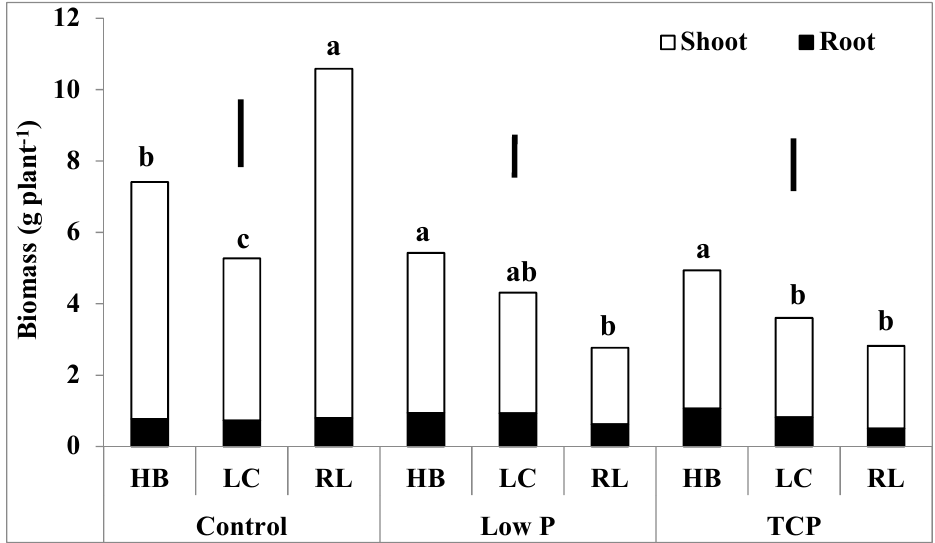
Figure 1. Total biomass of potato seedlings grown in modified Hoagland solution with different P bioavailabilities for 28 days. Histograms with different letters in the same treatment are different at p < 0.05. Control: 10 mg L − 1 P water soluble P as NaH 2 PO 4 ; Low P: 1 mg L − 1 P water soluble P as NaH 2 PO 4 ; and 286 mg L − 1 sparsely soluble P as TCP, tri-calcium phosphate, Ca 3 (PO 4 ) 2 with 2,286 mg L − 1 laboratory grade. HB: ‘Harley Blackwell’; LC: ‘La Chipper’; RL: ‘Red LaSoda’. The bars are the values of LSD 0.05, 2 for the plant biomass of the control, low P and TCP, respectively.